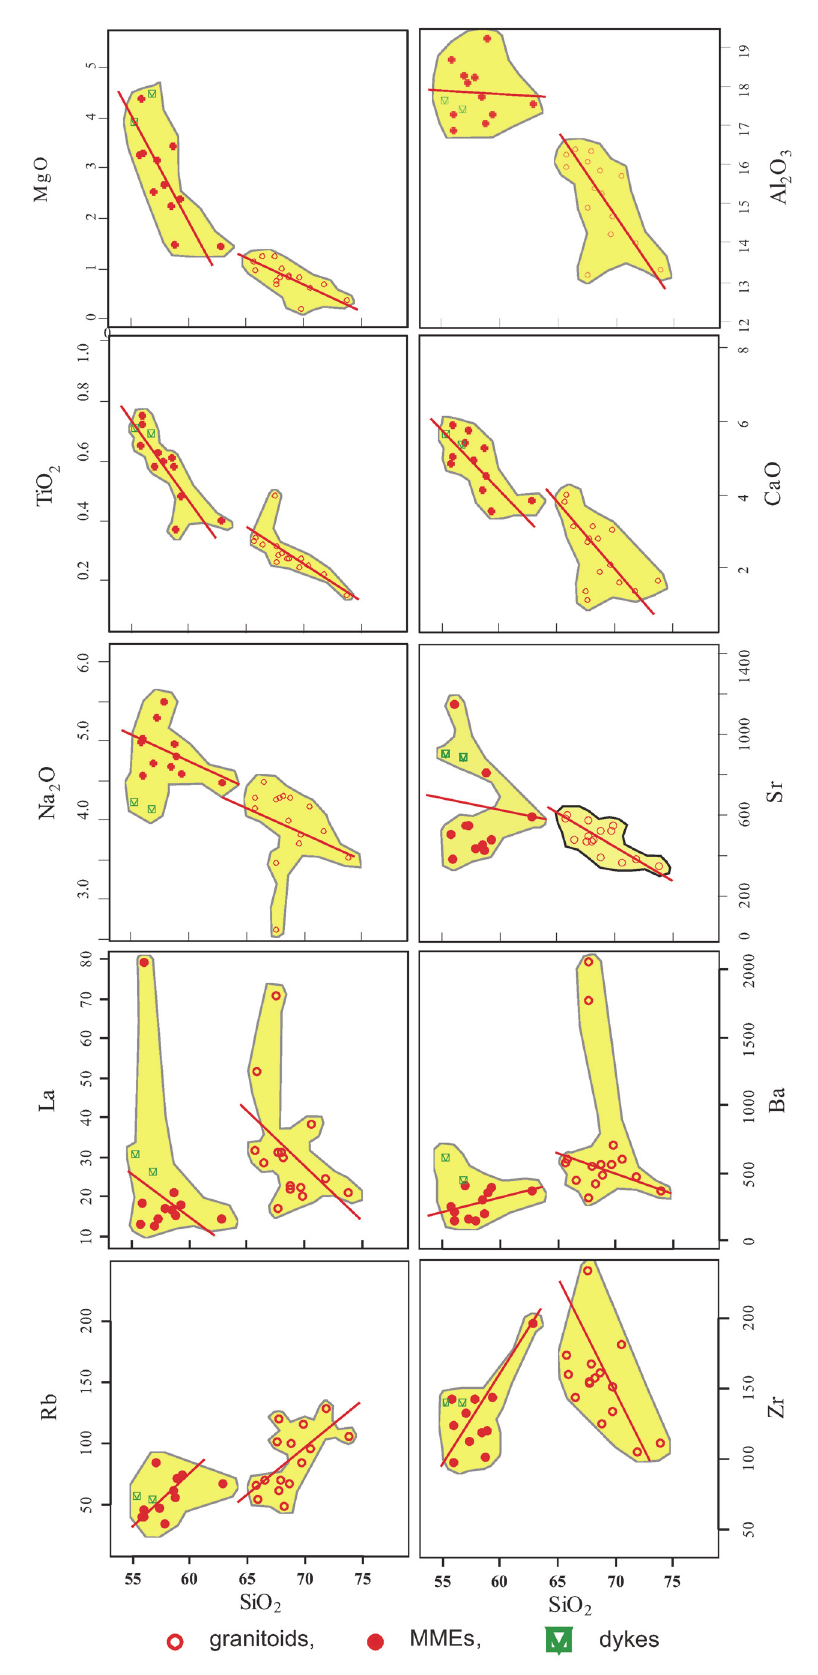
Fig. 5. Selected major and trace element Harker variation diagrams for samples from the Horoz granitoids, including dykes and